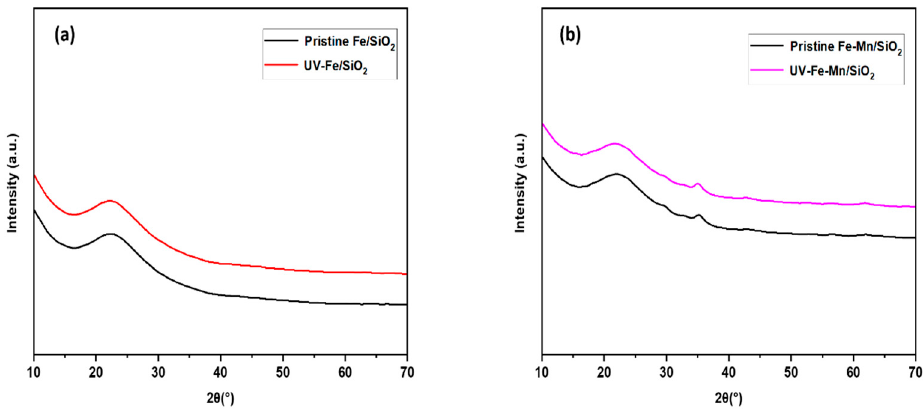
Figure 10. ( a ) XRD patterns ( a ) pristine and UV-irradiated Fe 2 O 3 /SiO 2 (Fe/SiO 2 ) ( b ) Fe 2 O 3 -Mn 2 O 3 /SiO 2 (Fe-Mn/SiO 2 ).